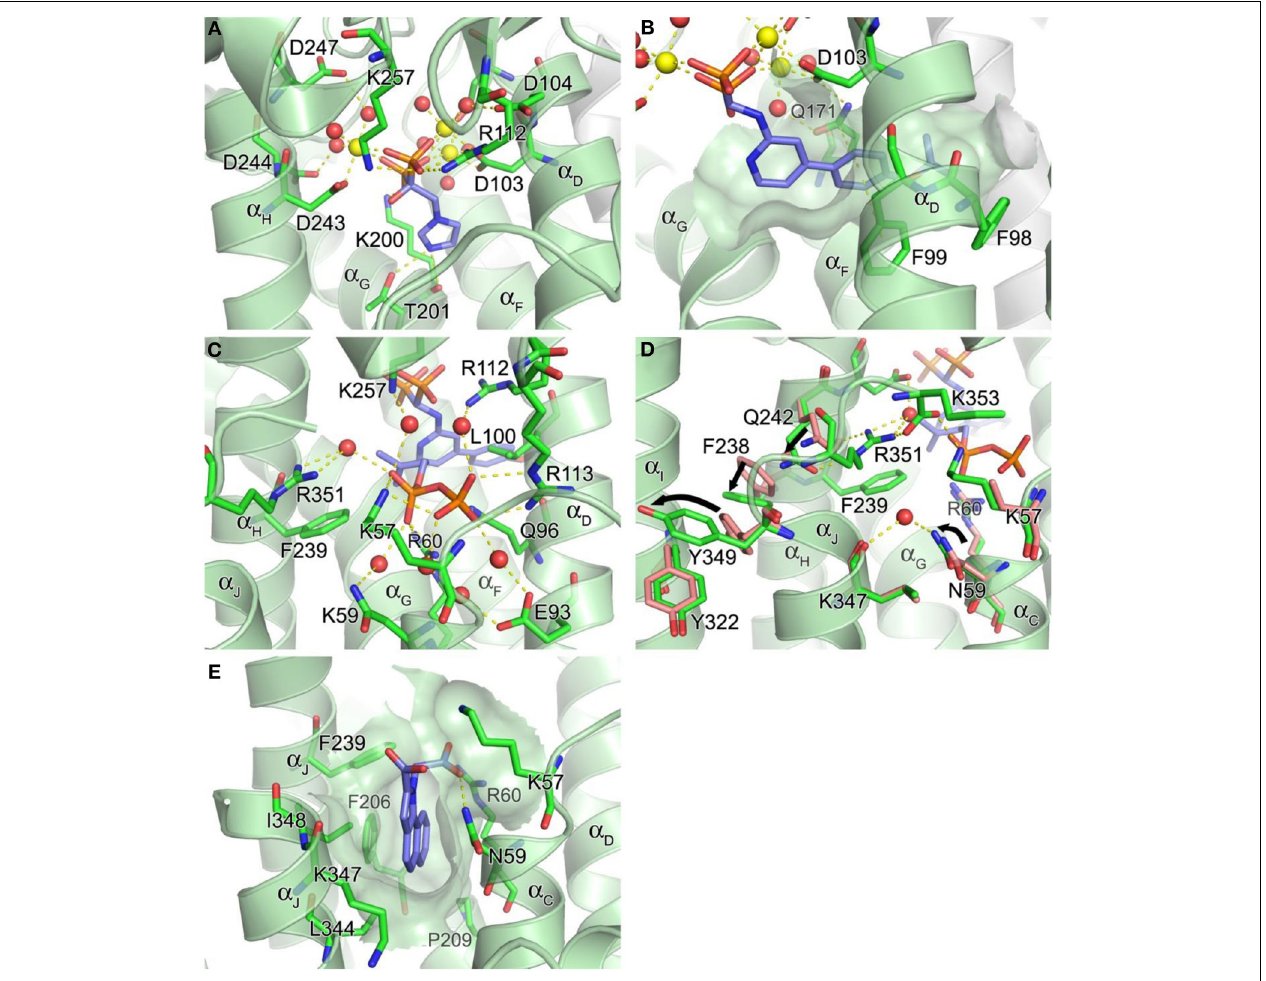
FIGURE 4 | Structure of human farnesyl pyrophosphate synthase. (A) Binding of zoledronate ( 1a ) at the allylic site (PDB ID: 2ZW5). Mg 2 + ions and water oxygen atoms are shown as yellow and red spheres, respectively. Yellow dashes indicate molecular interactions. (B) Binding of compound 8a (PDB ID: 4DEM). The hydrophobic channel